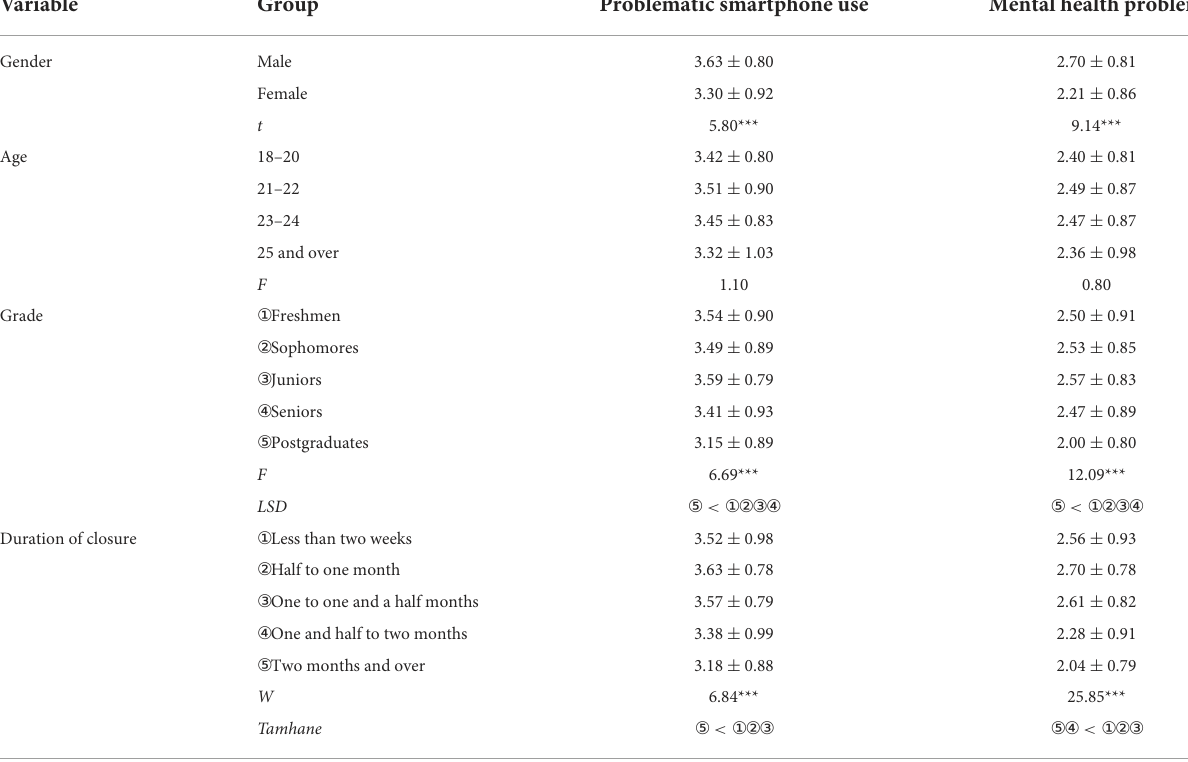
TABLE 1 Difference test for gender, age, grade, and duration of closure ( M ± SD ). Variable Group Problematic smartphone